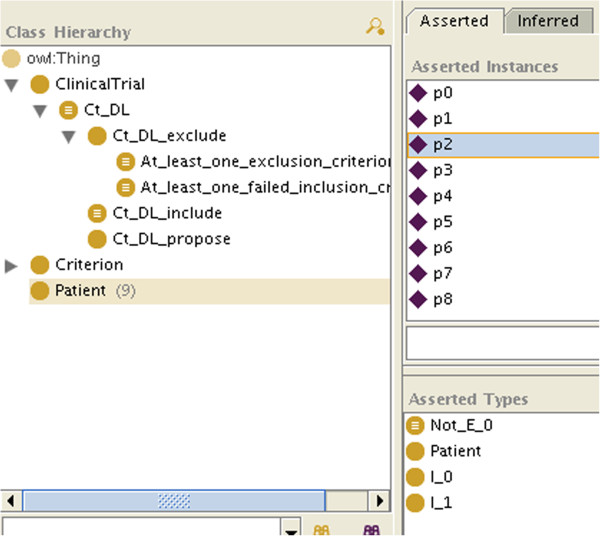
A patient for whom some information is unknown (here aboutE1).